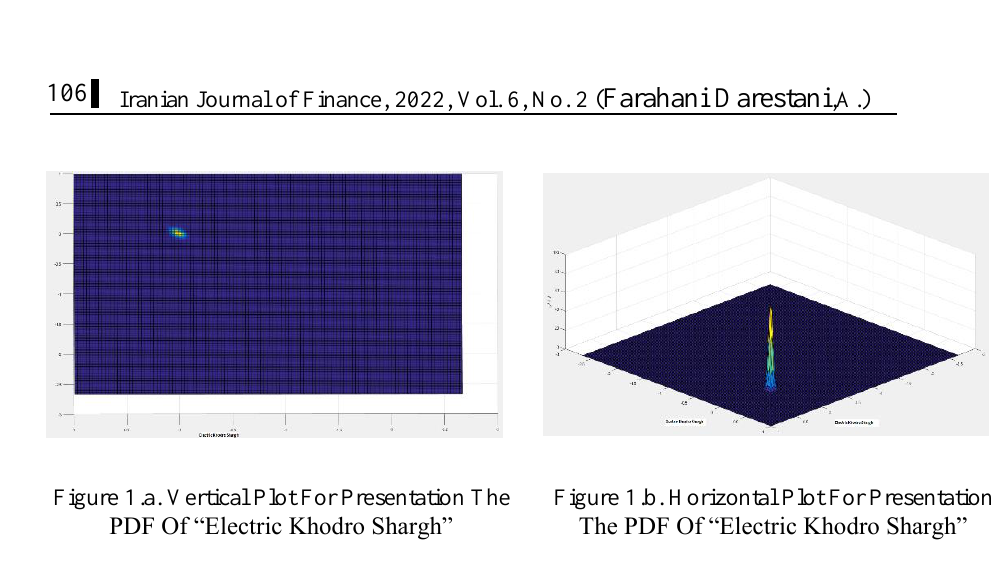
Figure 2.a. Vertical Plot for Presentation the Joint PDF of “Electric Khodro Shargh” and “Alborz Darou”